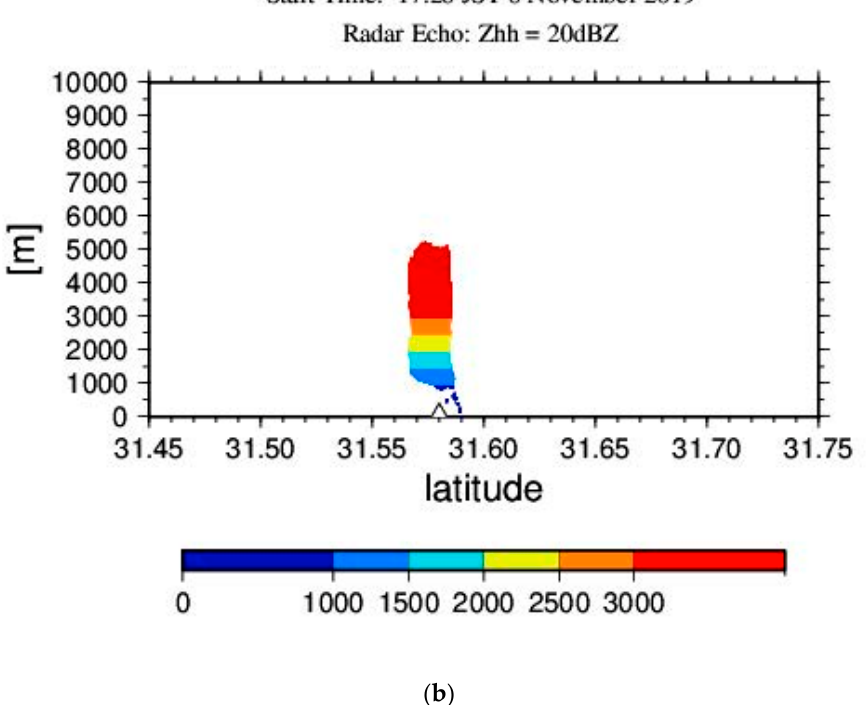
Figure 7. Ash plume dispersal by MP radar at 17:28 JST, in zonal-height (X-Z) and meridional-height (Y-Z) cross sections for the reflectivity factor ( Zhh ) larger than ( a ) 10 dBZ and ( b ) 20 dBZ. The colors of particles indicate different plume heights.